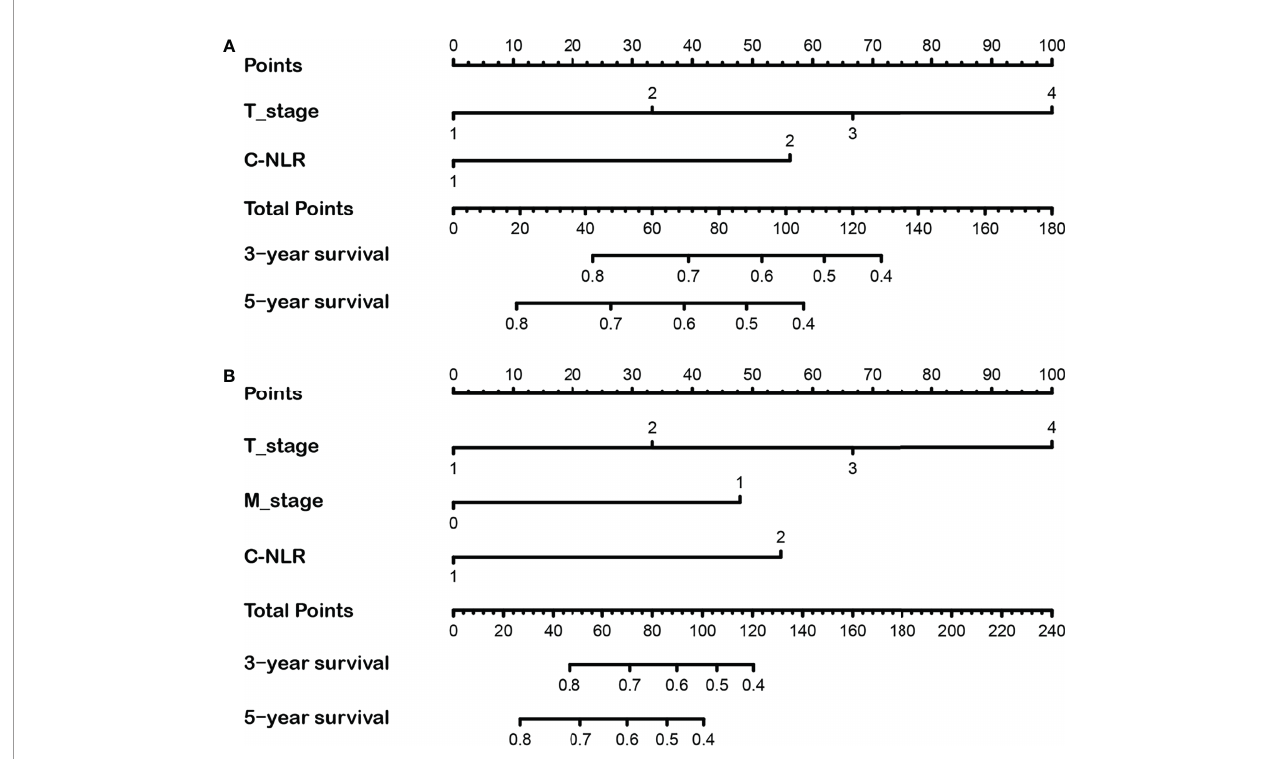
FIGURE 3 | The 3- and 5-year nomograms developed by the results of the multivariate analysis for overall survival (OS) (A) and disease-free survival (DFS) (B) of bladder cancer (BC) patients after radical cystectomy.